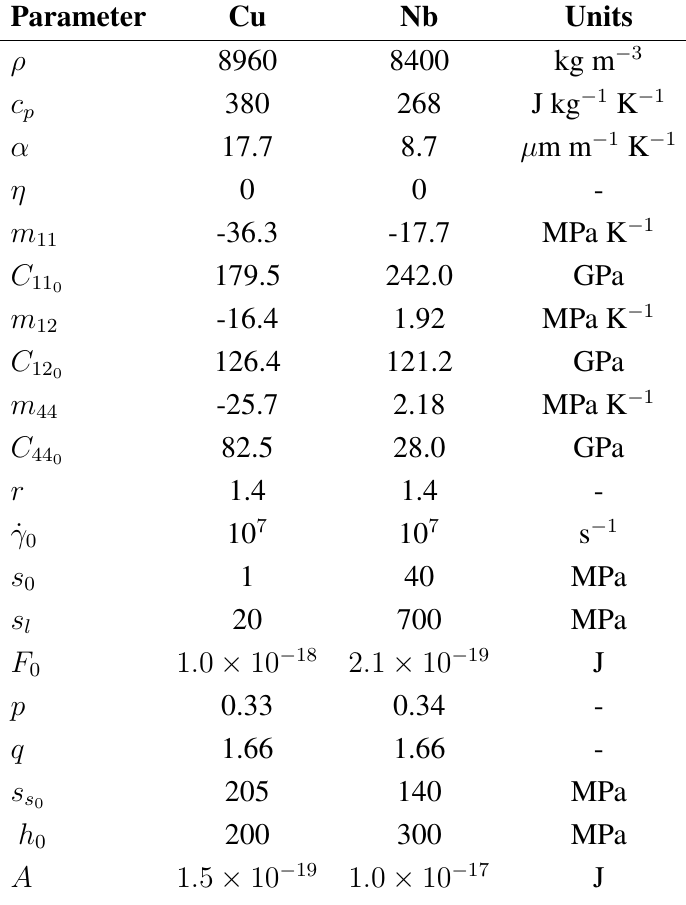
Table 2. Constitutive model